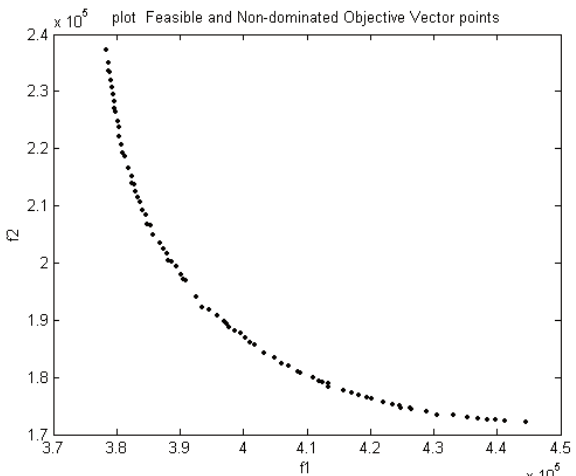
Fig. 9. Feasible domain with constraints on A11 and A22 with symetry